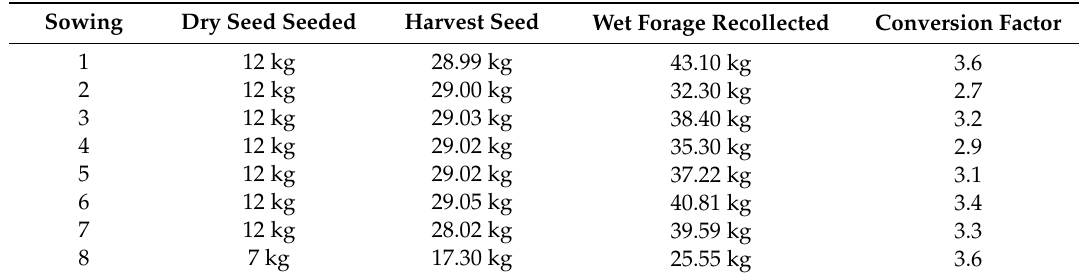
Table 4. Results of the hydroponic green forage of Zea mays for a production cycle of 15 days. Sowing Dry Seed Seeded Harvest Seed Wet Forage Recollected